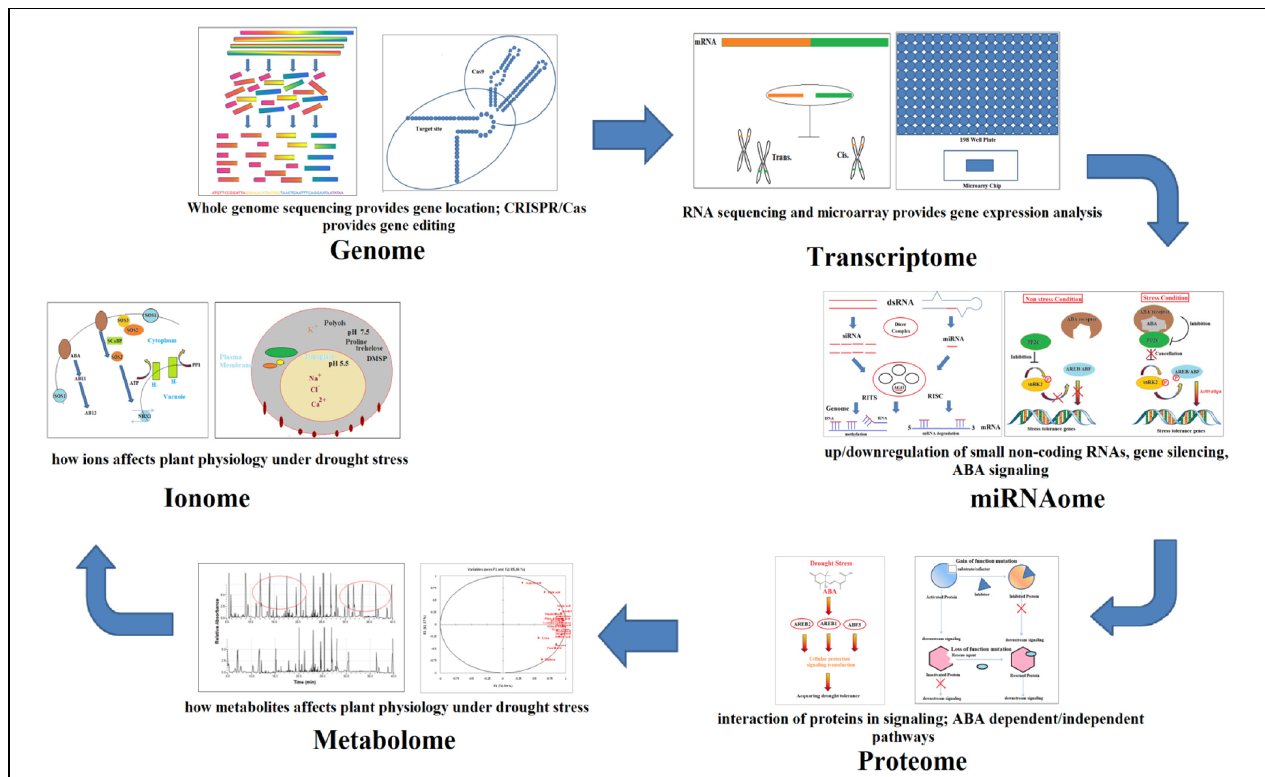
FIGURE 1 | Schematic diagram showing flow of information between functional genomics techniques for studying signaling pathways in plants.